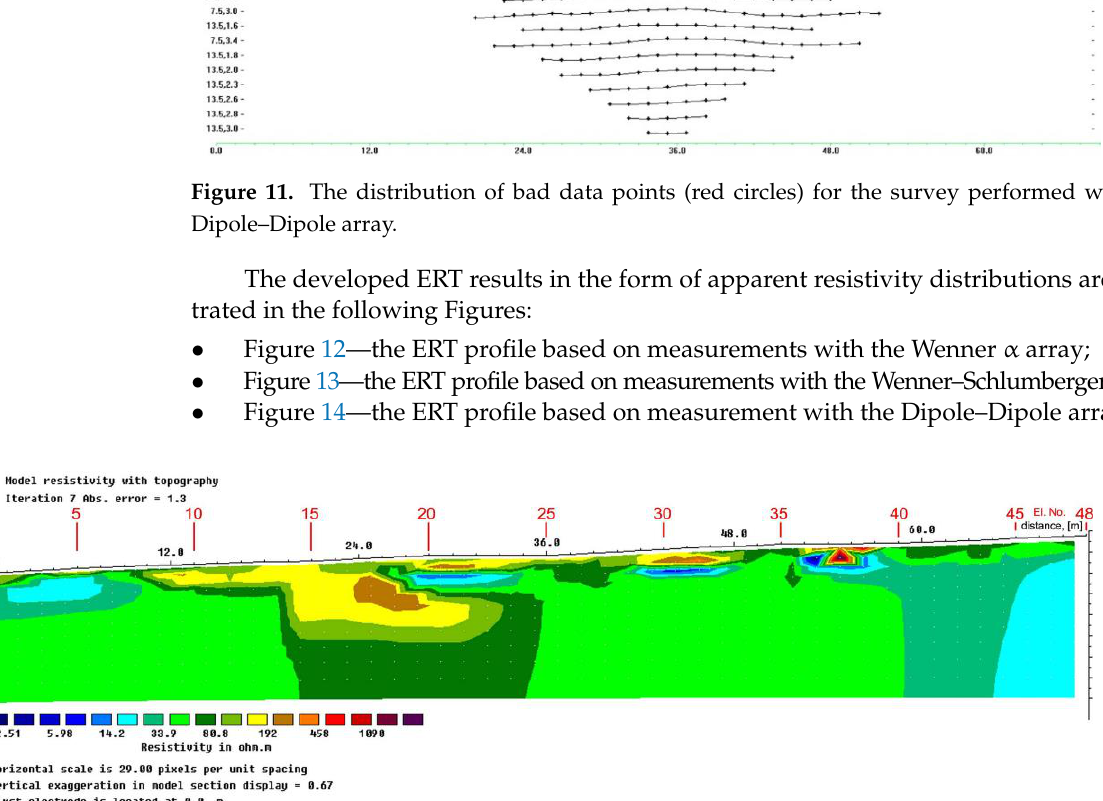
Figure 11. The distribution of bad data points (red circles) for the survey performed with the Dipole–